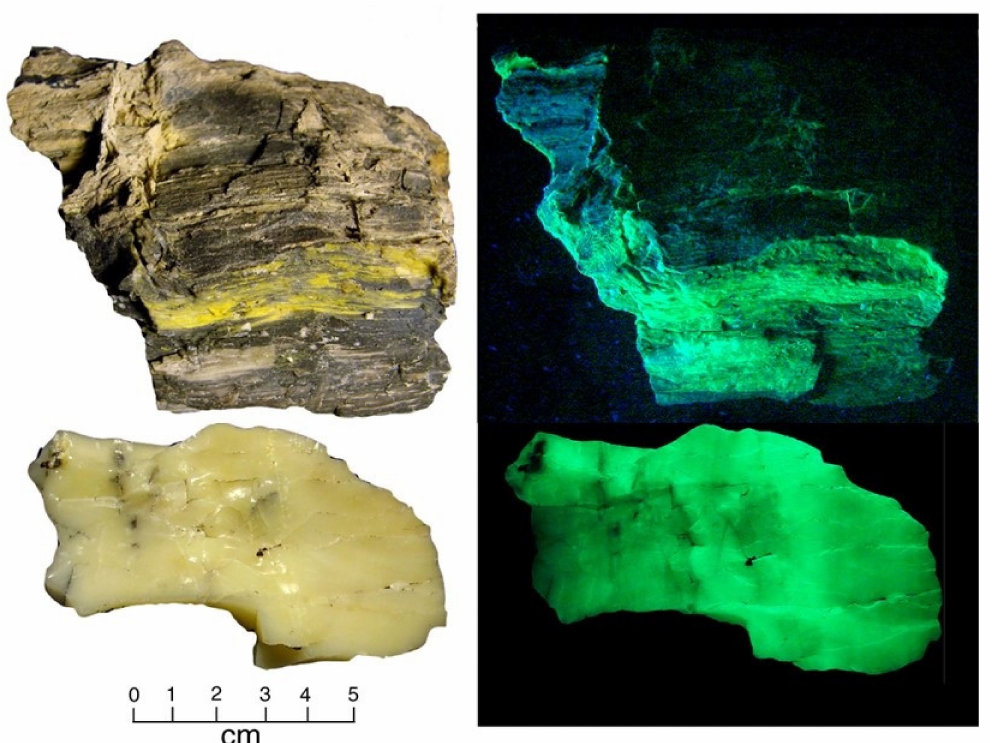
Figure 17. Miocene opalized wood from a uranium mining prospect in Mineral County, Nevada, USA, shows bright fluorescence under short-wave (254 nm) ultraviolet light. The upper specimen preserved wood grain texture, the lower specimen preserves no anatomical features; both were collected from the same stratum, which may represent accumulation of woody debris on the shore of an ancient lake